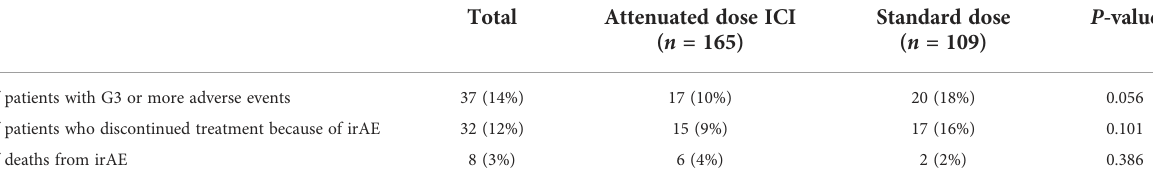
TABLE 5 Toxicity analysis of attenuated dose versus standard dose immune checkpoint inhibitors.